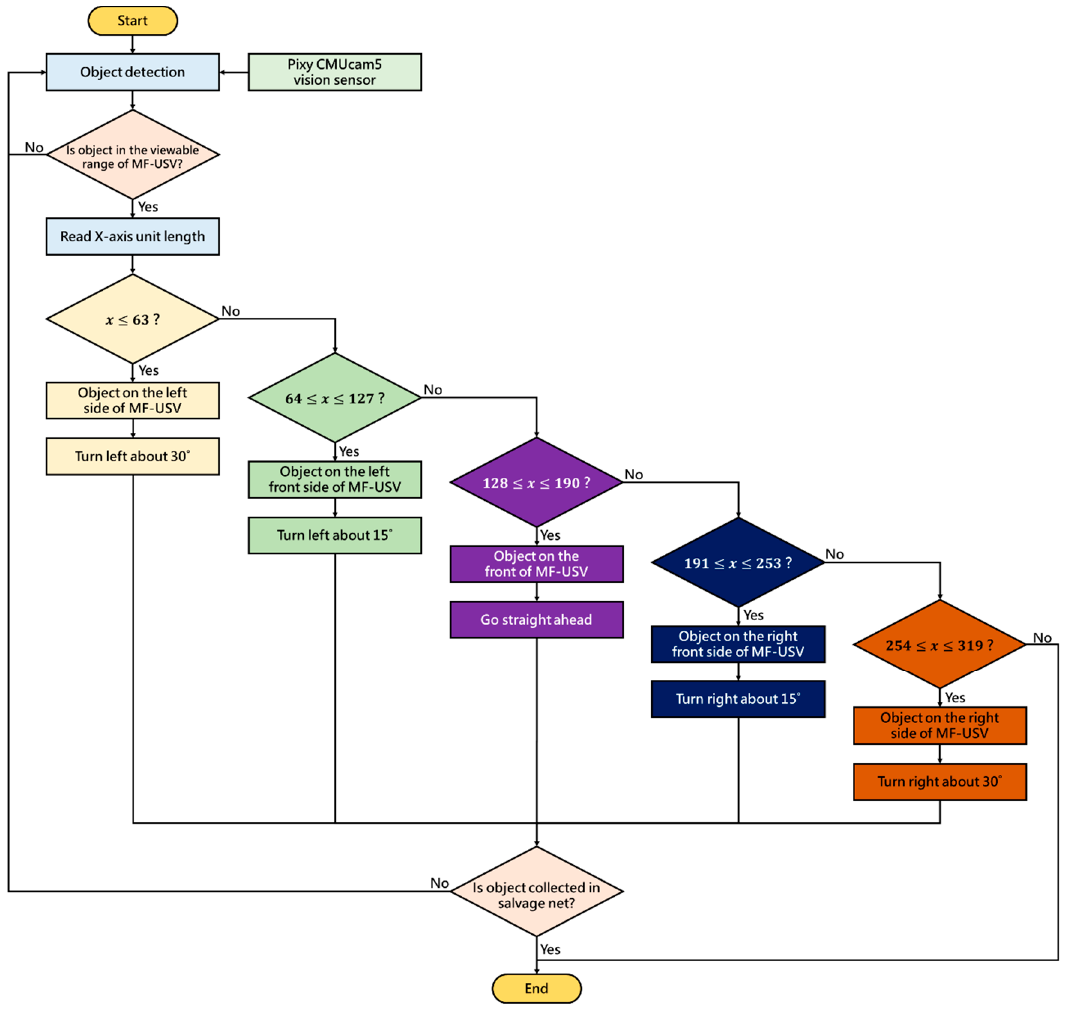
Figure 14. Water surface cleaning algorithm.